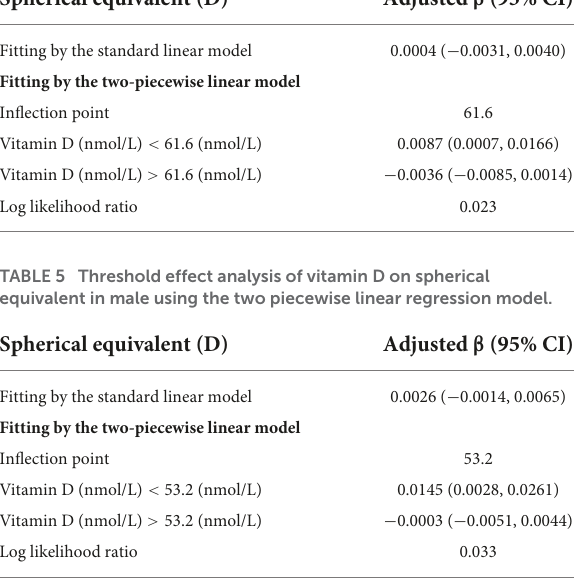
TABLE 4 Threshold effect analysis of vitamin d on spherical equivalent in female using the two piecewise linear regression model.